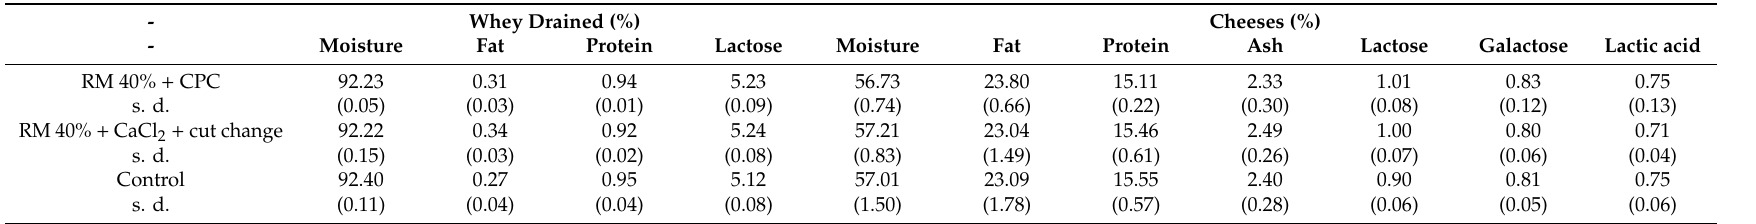
Table 5. Composition of the whey drained after manufacture and the Crescenza-type cheeses after maturation (7 days) using 40% recombined milk (RM), added